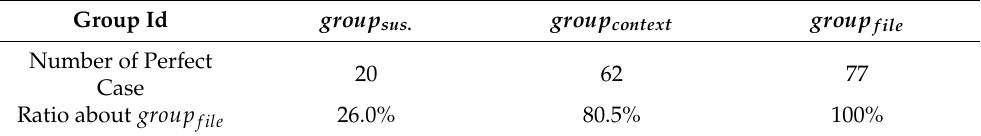
Table 4. Number of Perfect